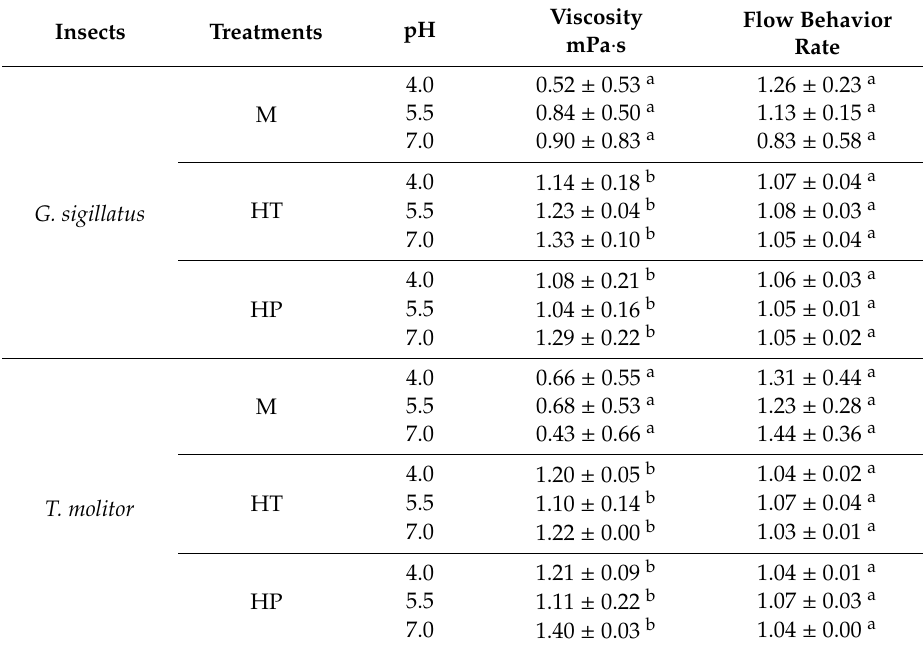
Table 4. Viscosity and flow behavior rate of insect meals and hydrolysates at di ff erent pHs, generated with or without HHP treatment prior to enzymatic